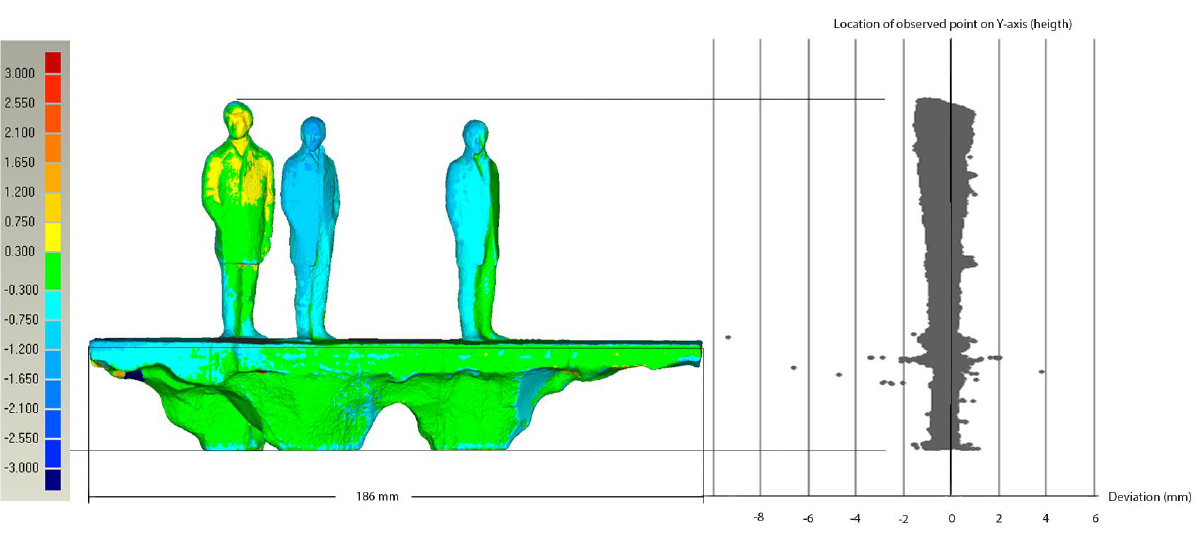
Figure 14. Deviation analysis and scatter of the Statue